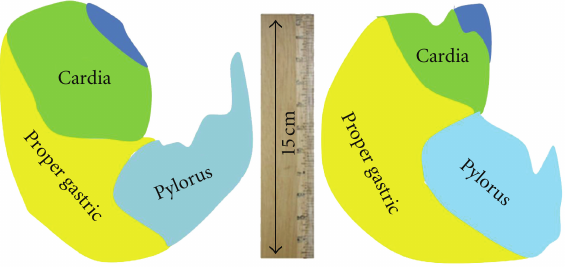
Figure 2: The comparative distribution of gastric regions between both breeds.